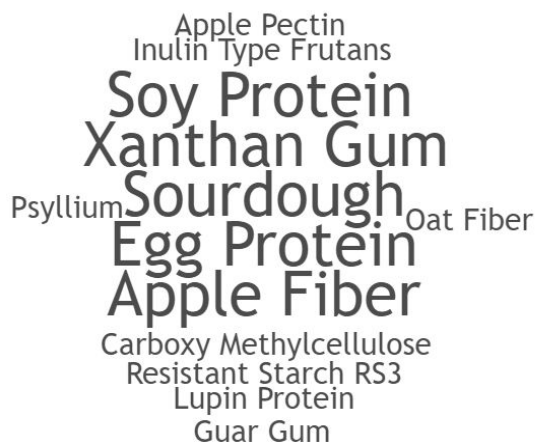
Figure 4. Word Cloud generated from GFB implemented gluten-replacements.